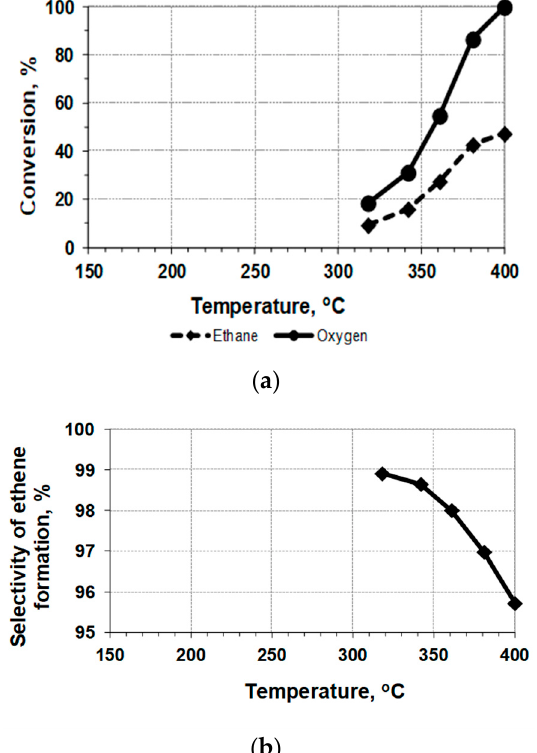
Figure 5. ODE with oven-heating of the sample Mo-V-Te-Nb-O x (0.144 g; 0.12 cc) diluted by quartz (1/1): ( a )—conversion of reagents; ( b )—selectivity of C 2 H 4 formation; gas mixture [78%C 2 H 6 + 22%O 2 ], flow rate = 600 cm 3 /h, GHSV = 2500 h − 1